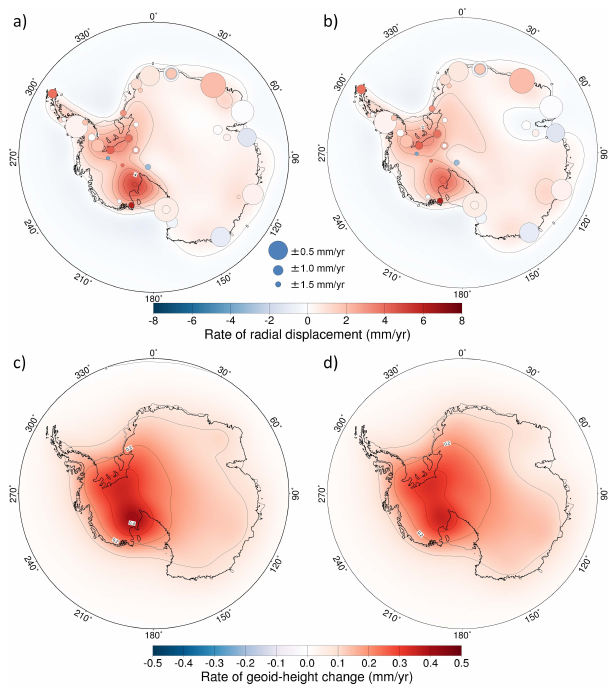
Fig. 4. Rate of radial displacement (mmyr − 1 ) and rate of geoid- height change (mmyr − 1 ), respectively, (a) and (c) for AGE1a (GPS only) and (b) and (d) for AGE1b (GRACE and GPS). Spherical- harmonic cut-off degrees are 0 to 170 for (a) and (b) and 2 to 60 for (c) and (d) . Also indicated are the GPS uplift rates (after the correction for the Northern Hemisphere contribution) according to Thomas et al.